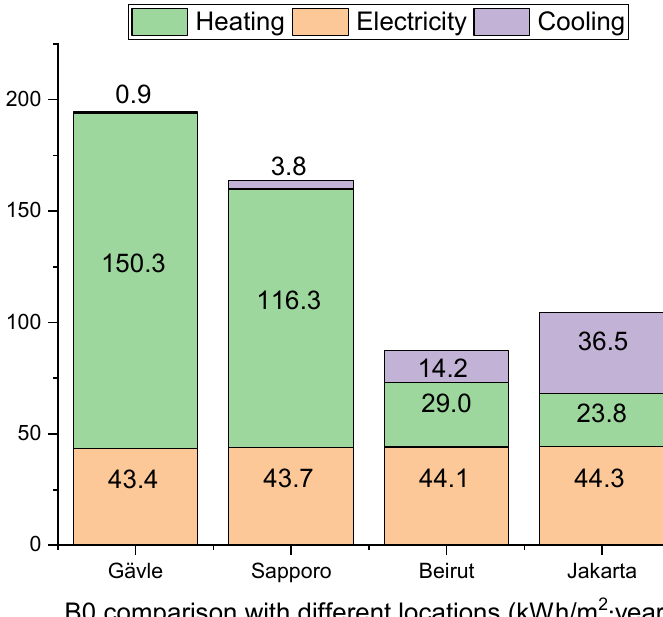
Figure 10. Comparison between energy usage for B0 in different locations.